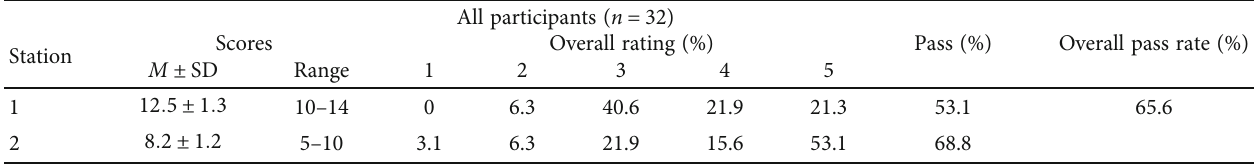
Table 4: Summary of students ’ scores at each station in the situated simulation-based